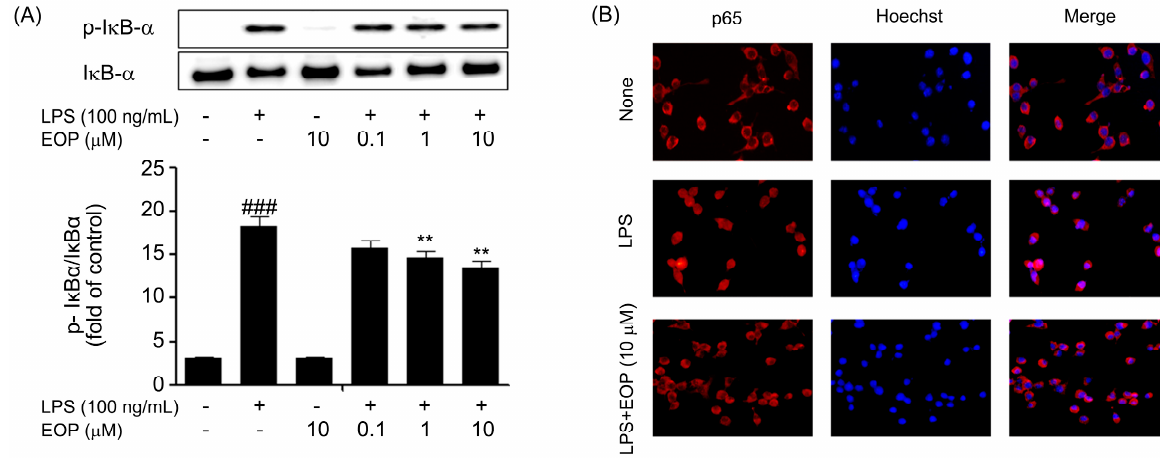
Figure 6. EOP inhibits the degradation of p-I κ B- α and further inhibits nuclear translocation of p65-NF- κ B in lipopolysaccharide (LPS)-stimulated BV-2 microglial cells. Cells were treated with the indicated doses of EOP, 60 min before LPS (100 ng/mL) treatment. Protein lysates were electrophoresed followed by immunoblotting using ( A ) anti-p-I κ B- α . Densitometric analysis of p-I κ B- α is shown in the lower panel. Results are expressed as a ratio of p-I κ B- α /T-I κ B- α . BV-2 microglial cells were seeded at a density of 5 × 10 4 cells/well on a 24-well plate. ( B ) Cells were treated with EOP (10 μ M) for 60 min and then stimulated with LPS (100 ng/mL) for 30 min. Sub-cellular location of the p65NF- κ B subunit was determined by an immunofluorescence assay. Data are the mean ± standard error of three independent experiments. ### p < 0.001 compared with the control group; ** p < 0.01 compared with